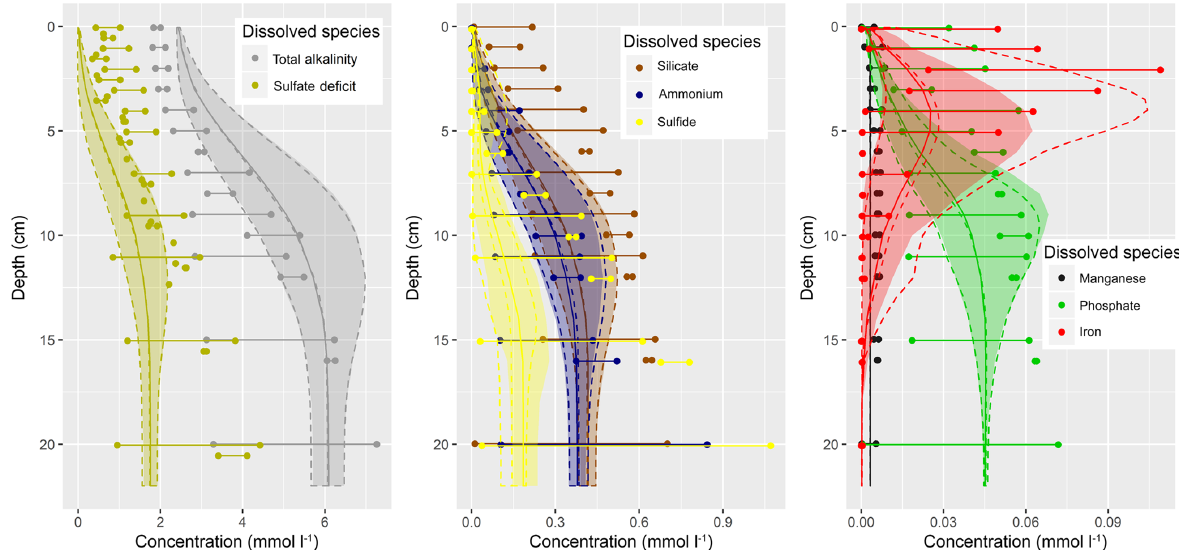
Figure E1. Pore water concentrations of several dissolved species at the silt station Tromper Wiek. Points and horizontal lines indicate the range of measurements. Solid curves and shading present the model results and indicate year-average concentrations and the seasonal range. Dashed curves show the same, but for a model version with double vertical